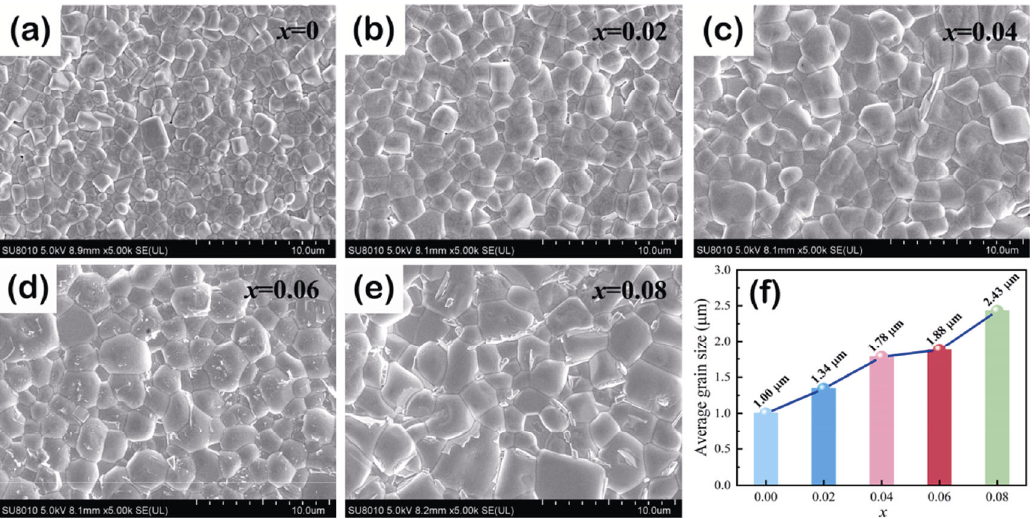
Fig. 3 SEM images of polished and thermally-etched surface of BNS 0.245 − 1.5 x (cid:0) 0.5 x B 0.325+ x T ceramics: (a) x = 0, (b) x = 0.02, (c) x = 0.04, (d) x = 0.06, and (e) x = 0.08; and (f) average grain size of BNS 0.245 − 1.5 x (cid:0) 0.5 x B 0.325+ x T ceramics as a function of x